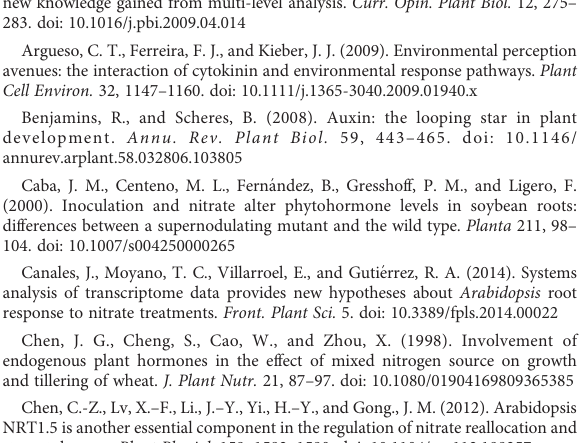
total nitrogen with E. coli DH5 a (TN + DH5 a ), total nitrogen with soil bacteria GB03 (TN + GB03), low nitrogen stress (LN), low nitrogen stress with E. coli DH5 a (LN + DH5 a ) and low nitrogen stress with soil bacteria GB03 (LN + GB03). Values are means ± SE ( n = 8). The different letters indicate signi fi cant differences at p < 0.05 (Duncan ’ s